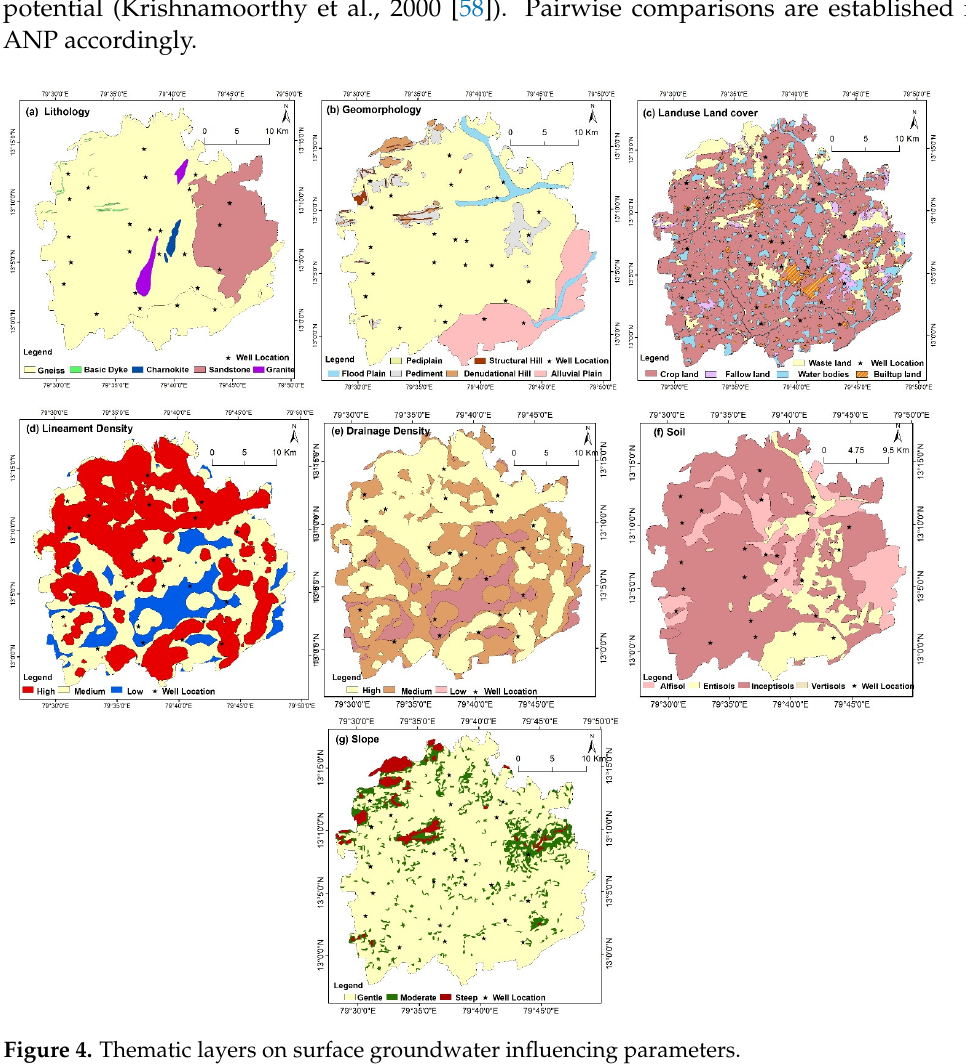
Figure 4. ( a – f ) Thematic layers on surface groundwater influencing